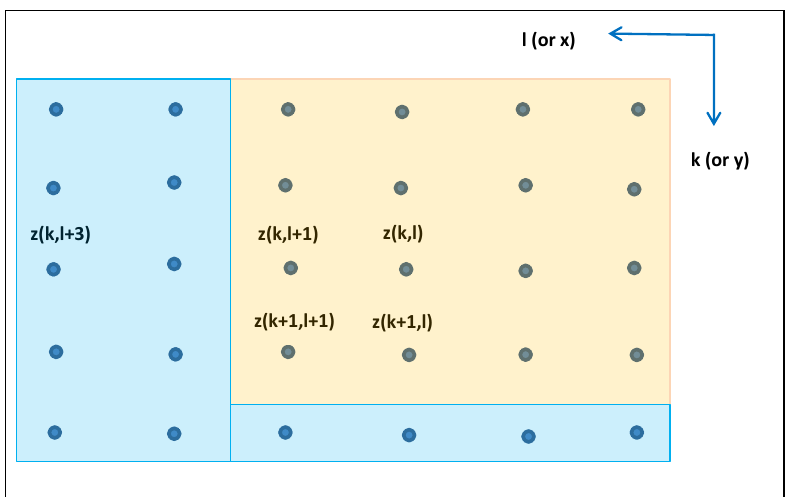
Figure 2. Horizontal grid of